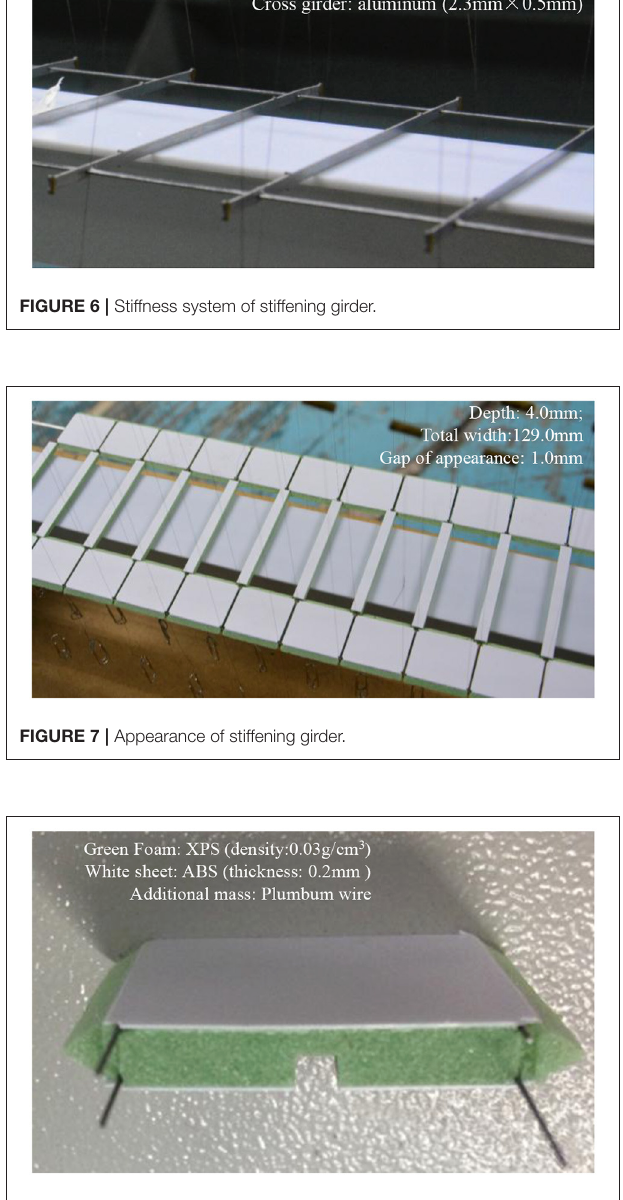
FIGURE 8 | Mass system of stiffening girder.